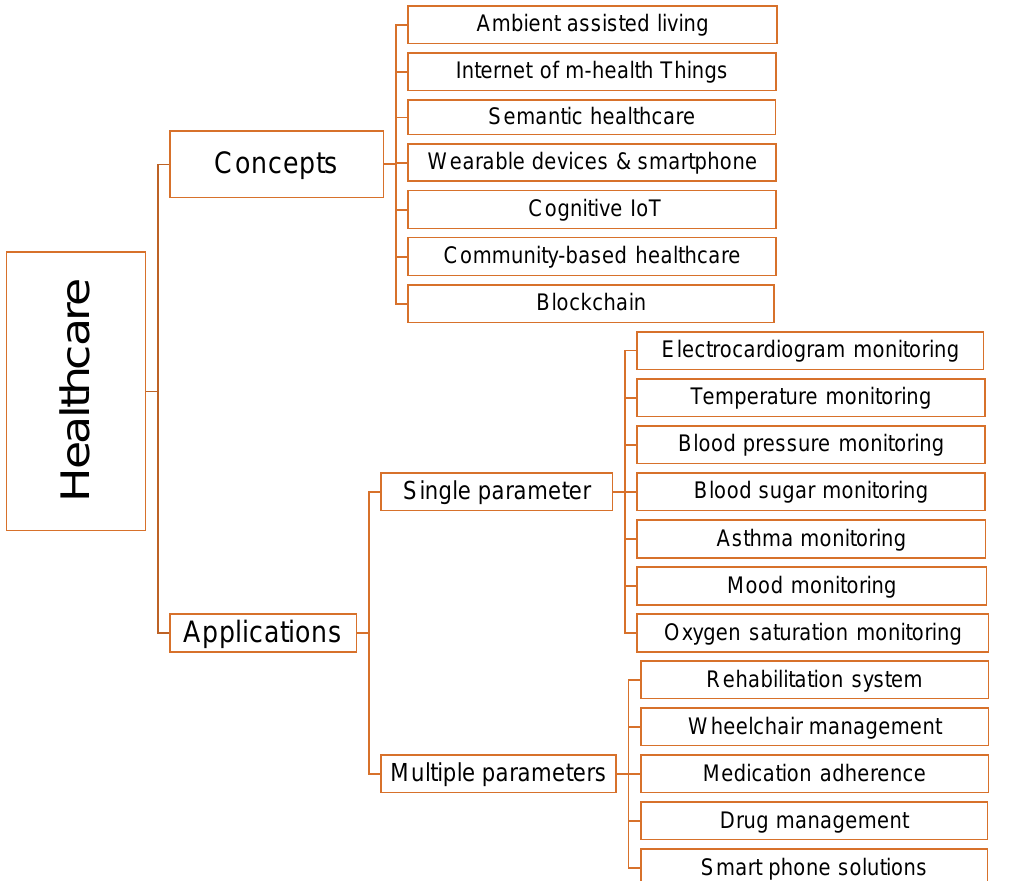
Figure 9. Classification of concepts, single parameter applications, and multiple parameters applications for IoT in healthcare.